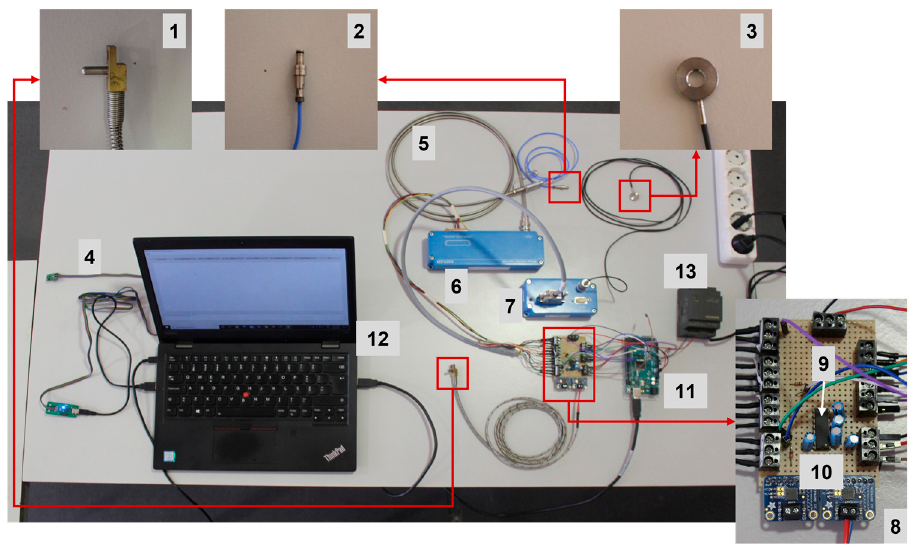
Figure 1. Monitoring system hardware with the components identi fi ed according to the numbers in Table 1.